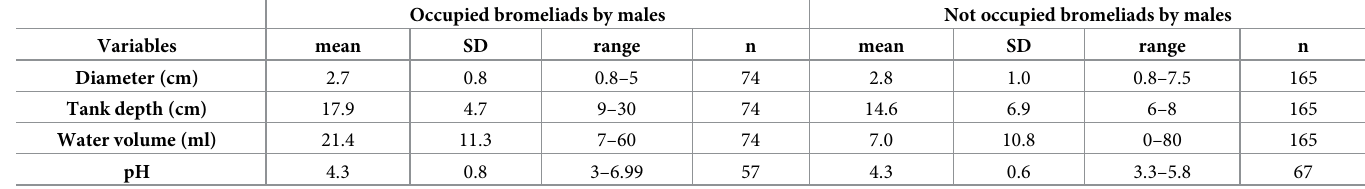
Table 1. Characteristics of bromeliads with Aparasphenodon arapapa males (occupied bromeliads) and without (not occupied bromeliads). Summary statistics shown use the full dataset of occupied bromeliads, without removing information of bromeliads with recaptured males. SD = standard deviation, n = number of bromeli- ads